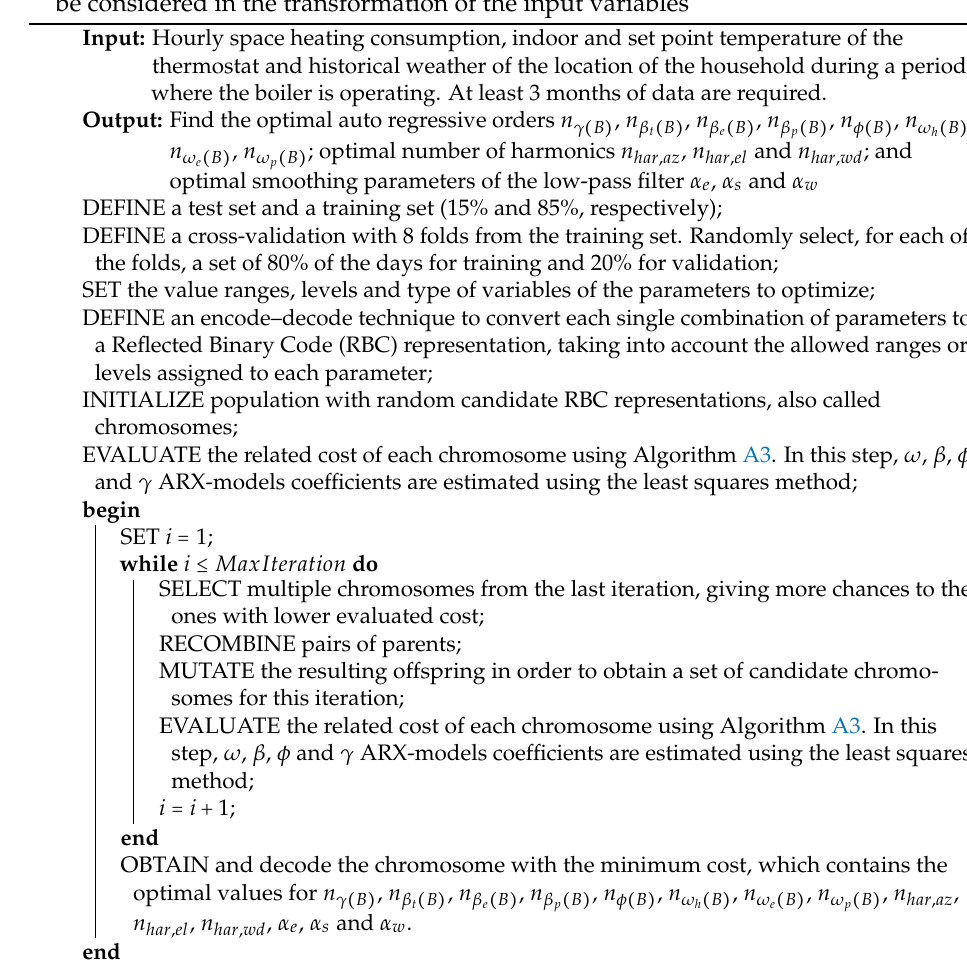
Algorithm A2: Genetic Algorithm for the optimization of the auto